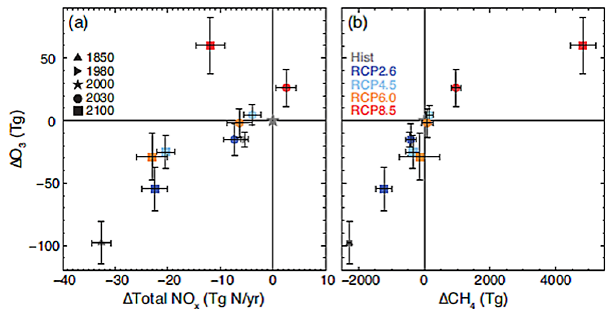
Figure 6. Ensemble mean change in the tropospheric ozone burden compared to the year 2000 simulation as a function of (a) changes in total NO x emissions and (b) changes in the tropospheric methane burden. Error bars indicate ± 1 SD of the changes in ozone, NO x emissions and methane burdens, calculated from the spread of the models. Different colours represent the different scenarios, whereas different symbols represent the different time slices (Young et al.,